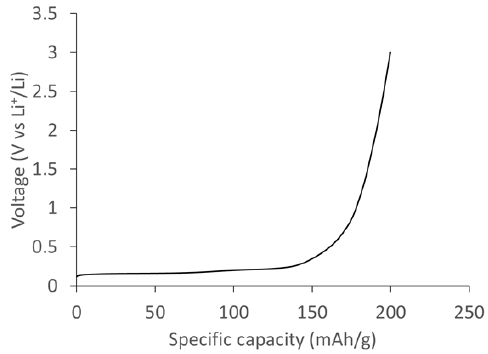
Figure 11. Delithiation capacity of prelithiated SCG electrode measured at a current density of 0.1 A/g when cycled between 0.01 and 3 V vs. Li + /Li.